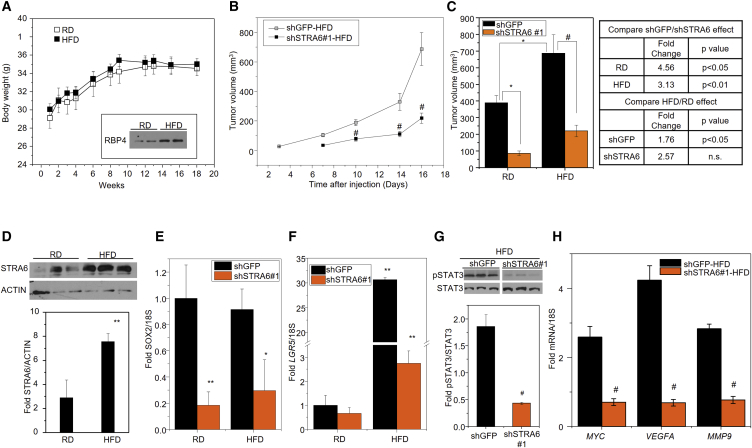
HFD Increases STRA6 and LGR5 in a Xenograft Model(A) Body weight of NCr nude mice fed either a regular rodent chow (RD) or a high-fat/high-sucrose diet (HFD) for 18 weeks. Arrow indicates the time point (15 weeks) at which cells were injected. Inset: immunoblot of RBP4 in serum of RD- or HFD-fed mice after 15 weeks. Data are mean ± SEM (n = 10 mice).(B) NCr male mice in (A) were injected with 5 × 106 SW480 cells stably expressing GFP shRNA or STRA6 shRNA after 15 weeks on HFD. Tumor growth at both injected sites was monitored twice a week. Data are mean ± SEM (n = 7–9 tumors). #p < 0.01(C) Tumor volumes at endpoint of the experiment in (A). Data are mean ± SEM (n = 7–9 tumors). ∗p < 0.05; #p < 0.01. Fold changes in tumor volume between different conditions and their statistical analysis is shown in the table on the right.(D) (Top) Immunoblot for STRA6 in tumors at endpoint in (A). (Bottom) Quantification of the immunoblot. Data are mean ± SEM (n = 3 tumors). ∗∗p < 0.05.(E and F) Expression levels of SOX2 (E) and LGR5 (F) in tumors at endpoint in (B). Data are mean ± SEM (n = 3–5 tumors). ∗p < 0.01; ∗∗p < 0.05.(G) Immunoblot for pSTAT3 in tumors arising from SW480 stable lines in mice fed an HFD (top) and the quantification of the immunoblot (bottom). Data are mean ± SEM (n = 3 tumors). #p < 0.01(H) Expression levels of STAT3 target genes in the same tumors in (G) from mice fed an HFD. Data are mean ± SD (n = 3 tumors). #p < 0.01.